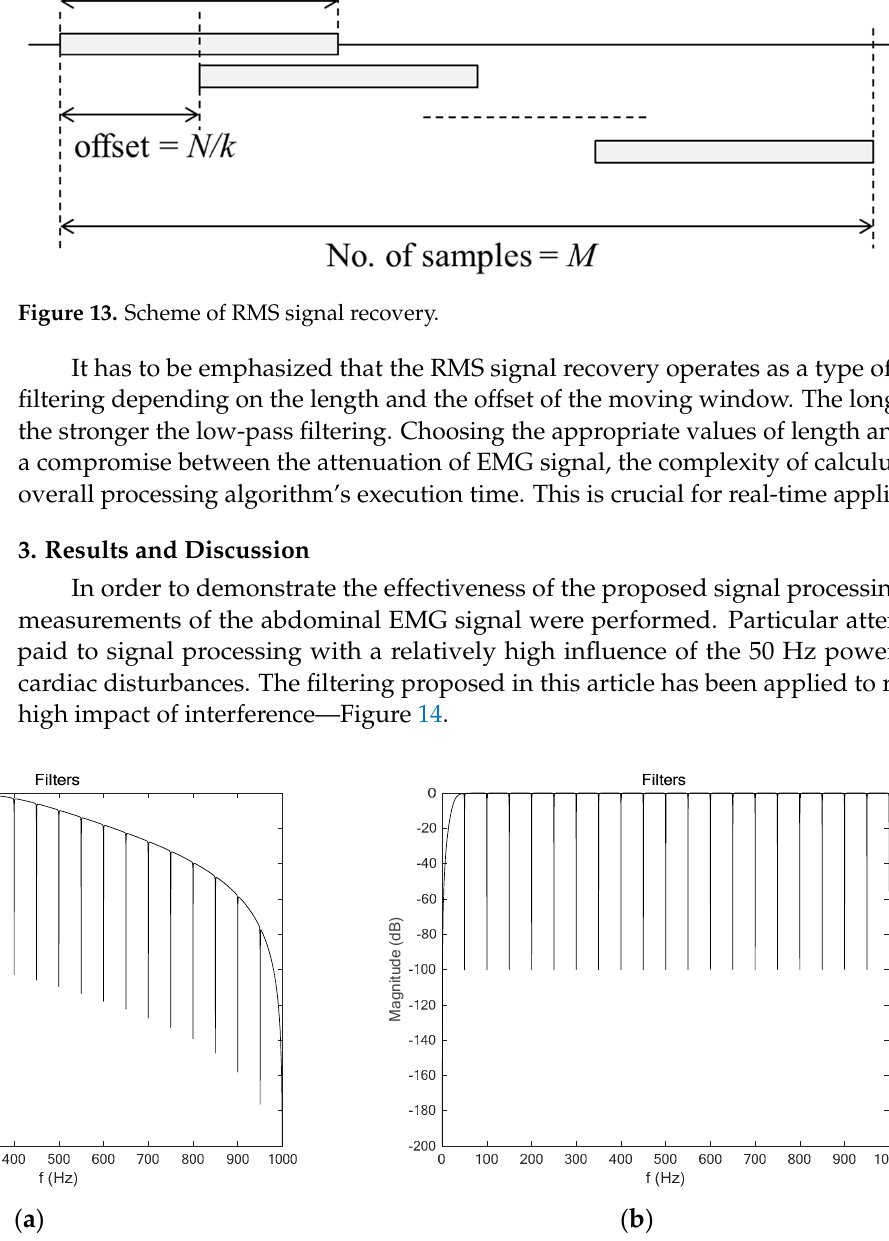
Figure 14. Examples of filters’ characteristics for EMG signals, ( a ) magnitude of 3rd order BP filter ( f lc = 30 Hz, f hc = 400 Hz) and 40th order comb filter for ∆ f = ±0.5 Hz, ( b ) magnitude of 3rd order HP filter ( f c = 30 Hz) and 40th order comb filter for ∆ f = ±0.5 Hz.